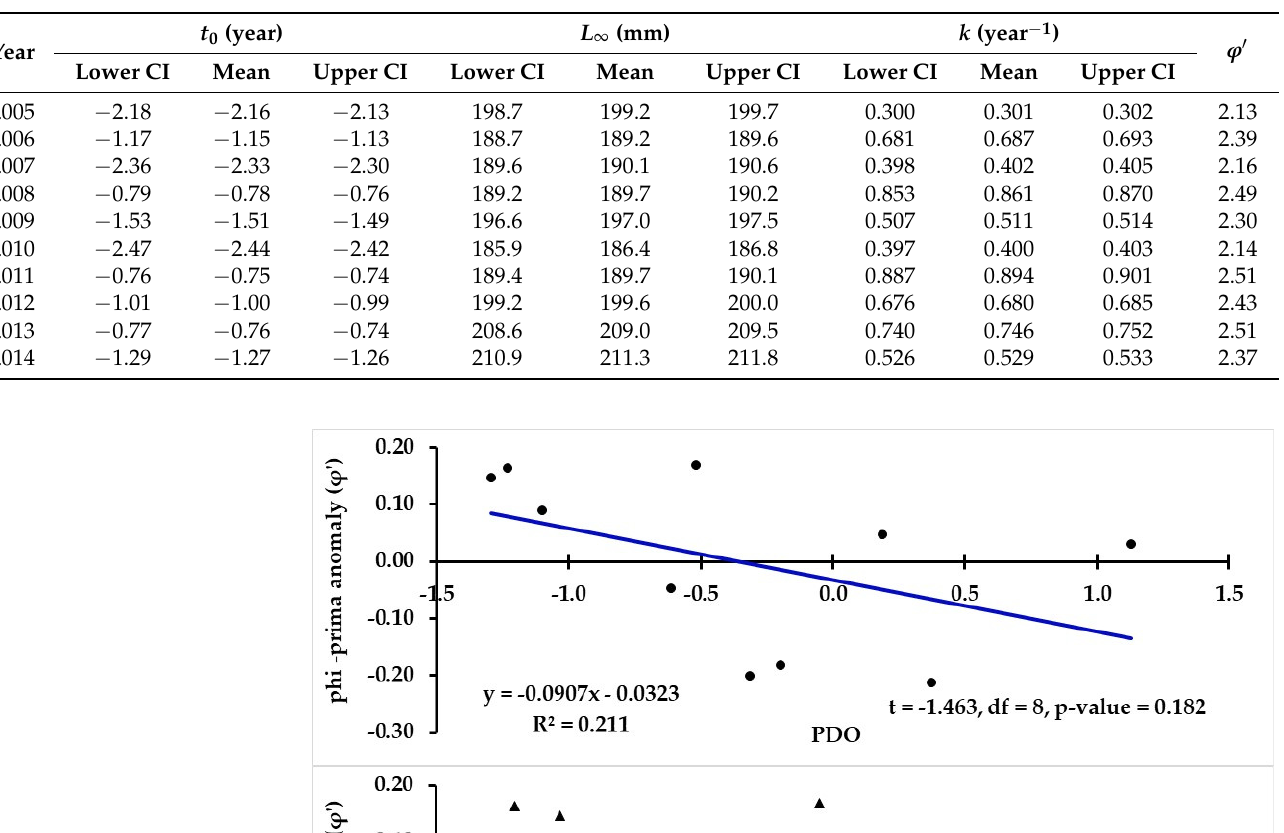
Table 9. Annual average values and 95% confidence intervals (CI; α = 0.05) of the parameters t 0 , k, L ∞ , and phi-prima ( ϕ (cid:48) ) obtained from von Bertalanffy growth model for temperate Sardinops sagax stock in the southern California Current System (CCS).